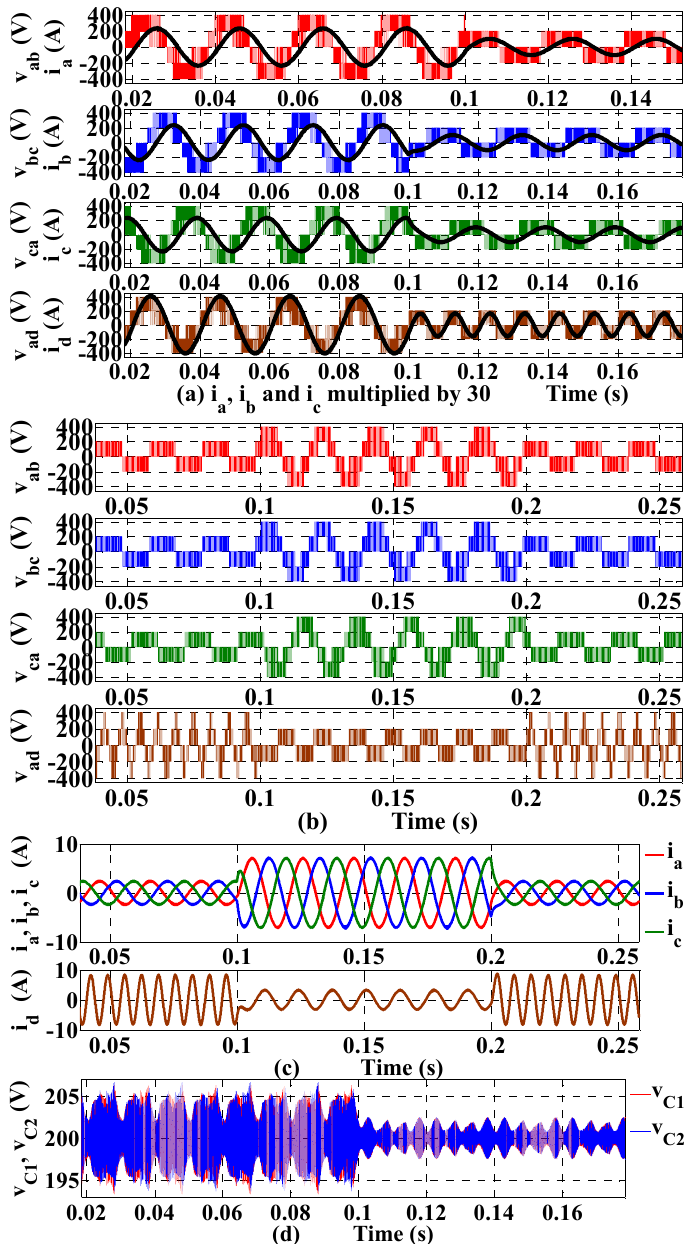
Figure 7. Simulated output voltage and current waveforms of the dual-phase inverter for common and different frequency operations. ( a ) Common 50 Hz and modulation indices of 1.1547 and 1 at frequencies of 50 and 100 Hz, with common modulation index of 0.7559; ( b , c ) different frequencies of 50 and 150 Hz, with modulation indices of 0.35 and 0.8 at different frequencies of 50 and 75 Hz, with modulation indices of 1.05 and 0.25; ( d ) capacitor banks’ voltages in ( a ).